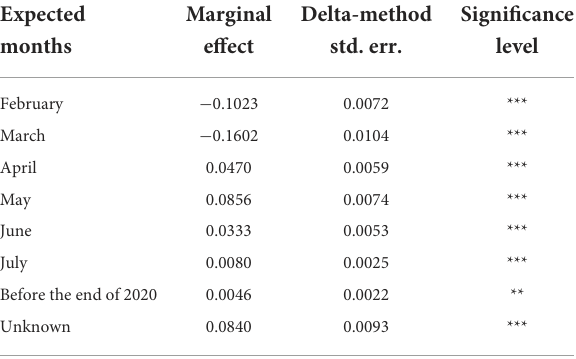
TABLE 8 Marginal effect analysis of the residents’ expected month for controlling COVID-19 outbreak at the destination cities.